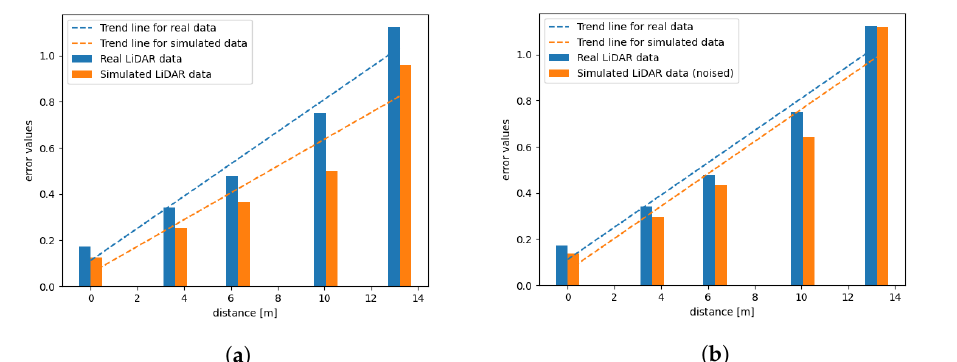
Figure 12. SLAM accuracy metric for real data and simulated data generated for the second track: ( a ) without noise and with the rolling shutter effect ( b ) with added noise and the rolling shutter